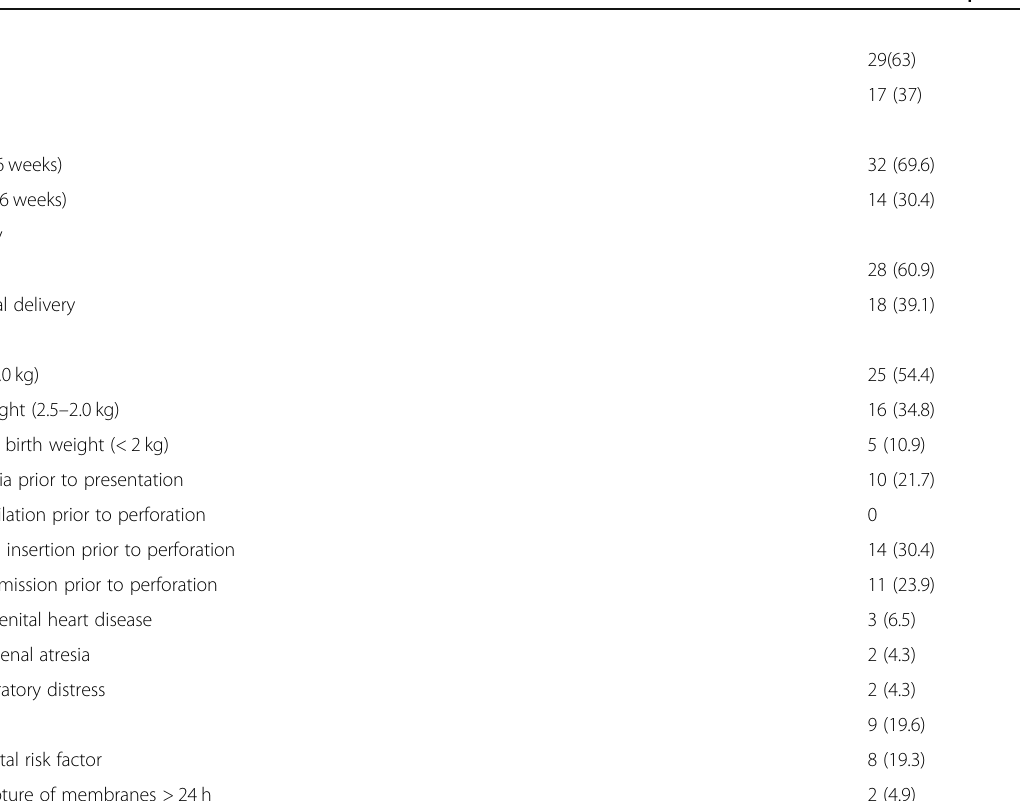
Table 1 Demographic and clinical details of patients ( n =46)